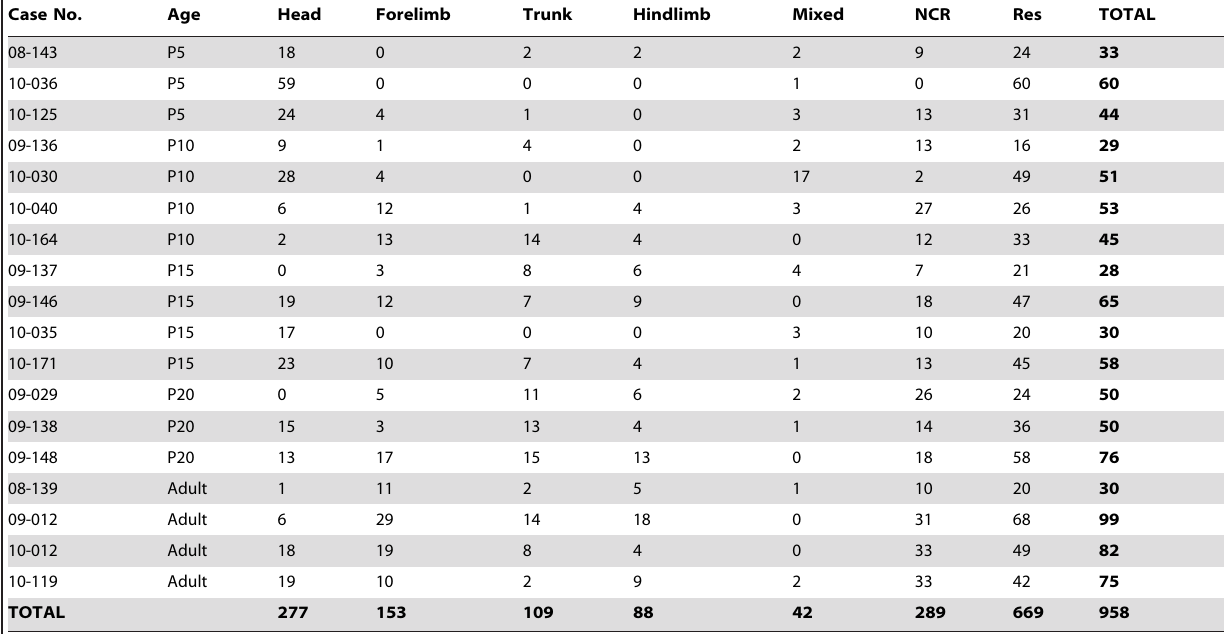
Table 5. Recording